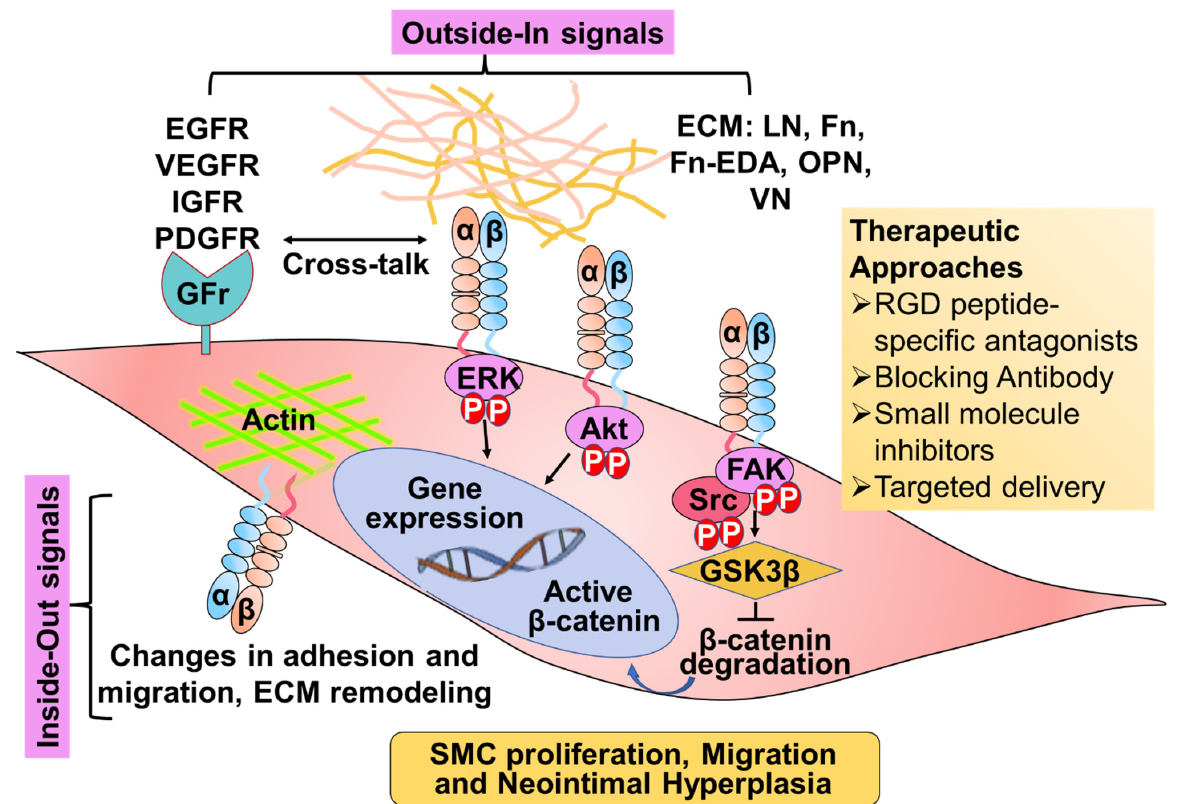
Figure 1. Schematic showing the signal transduction pathways regulated by integrins in smooth muscle cells (SMC). Depending on the type of integrin and its expression on SMCs, they can trigger signals promoting synthetic or paradoxically a contractile SMC phenotype. Many of the reported SMC-specific integrins promote synthetic SMC phenotype. For example, integrin binding to extracellular matrix (ECM) or activation of growth factor receptors (GFr) facilitates downstream signaling events via FAK-Src, Akt, or ERK pathway, resulting in SMC proliferation and migration and neointimal migration hyperplasia. Abbreviations: ERK: extracellular signal-regulated kinase; ECM: extracellular matrix; EDA: extra domain A; FAK: focal adhesion kinase, Fn: Fibronectin; IGFR: insulin-like growth factor receptor; LN: Laminin; OPN: Osteopontin; PDGFR: platelet-derived growth factor receptor; VEGFR: vascular endothelial growth factor receptor; VN: Vitronectin. Integrin–ligand interactions play a crucial role in remodeling of the injured vessel wall during wound healing, arterial stent injury, and in maintaining typical vascular structure [32]. Several integrins contribute to SMC activation. The major α -integrin subu- nits present in SMC are α 1, α 3, α 5, α 8, and α 9 [10,33], whereas β subunits are β 1, β 3, and